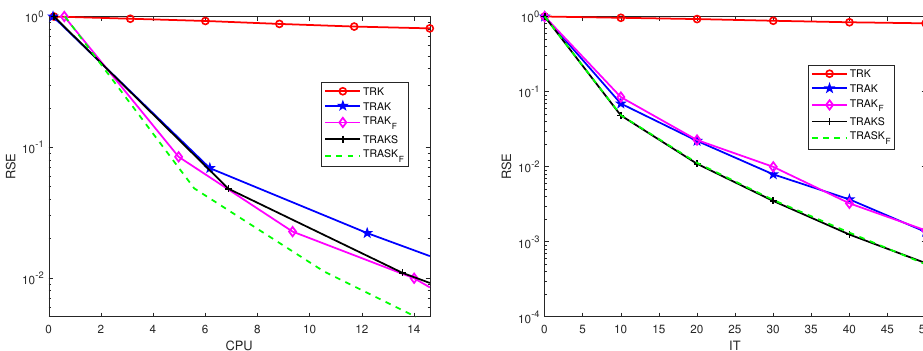
Figure 9. Pictures of the average RSE versus IT and CPU times for the TRK, TRAK, TRAK F , TRAKS, and TRAKS F algorithms when X is a CT data.